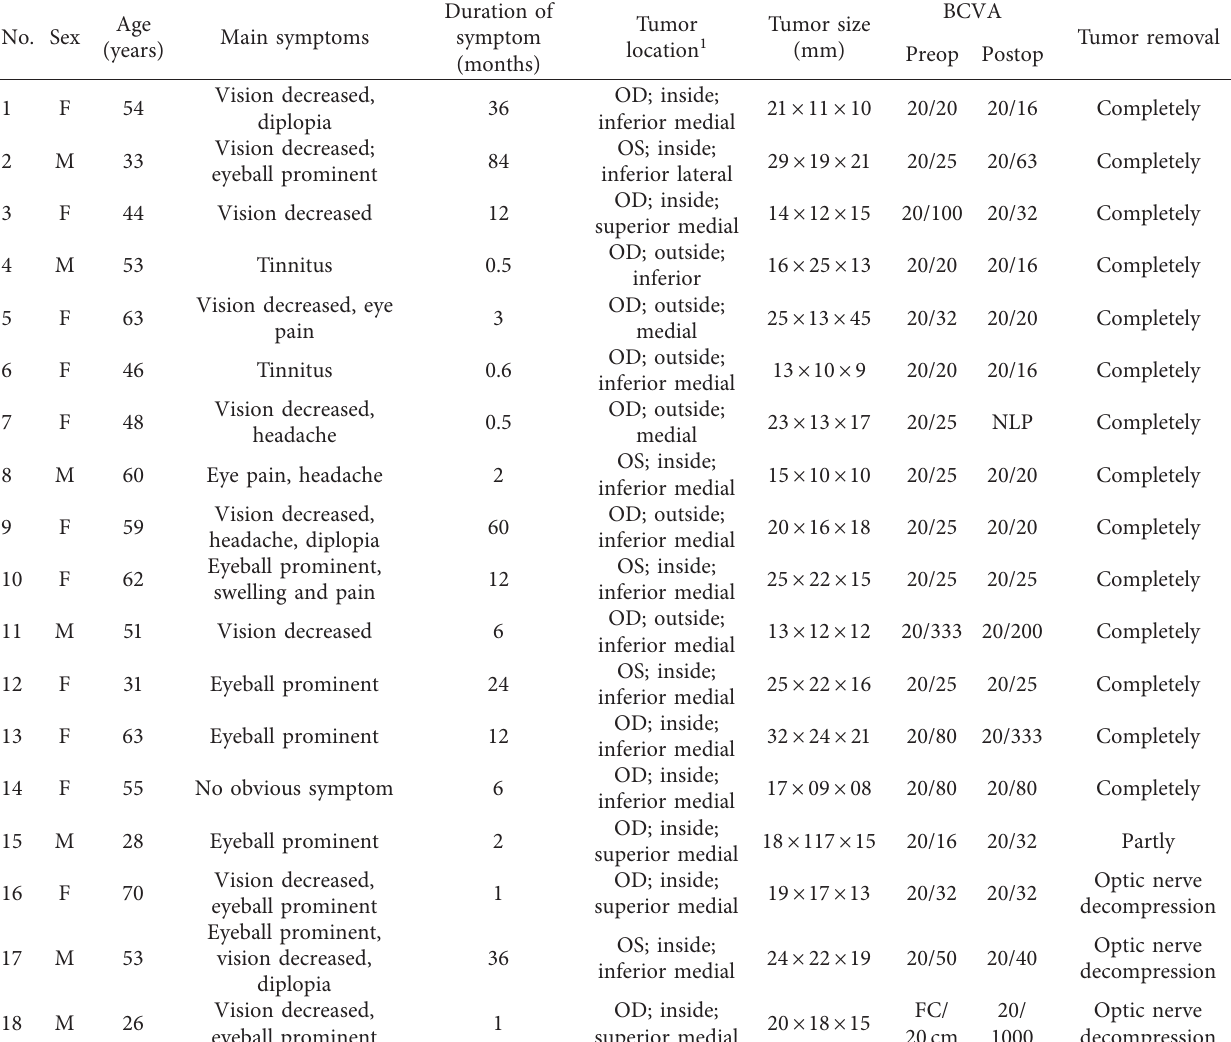
Table 1: Clinical characteristics and surgical outcomes of patients with OACH involving orbital